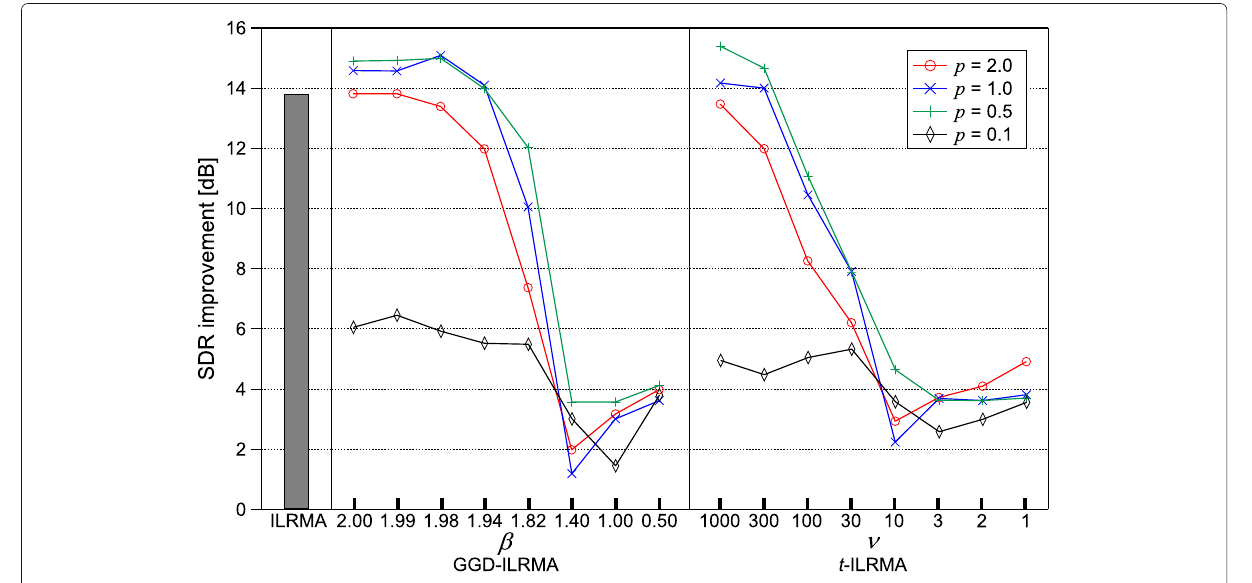
Fig. 25 Average SDR improvements of longer Music 1 signal (10.0 s) with E2A_1 using fixed parameters